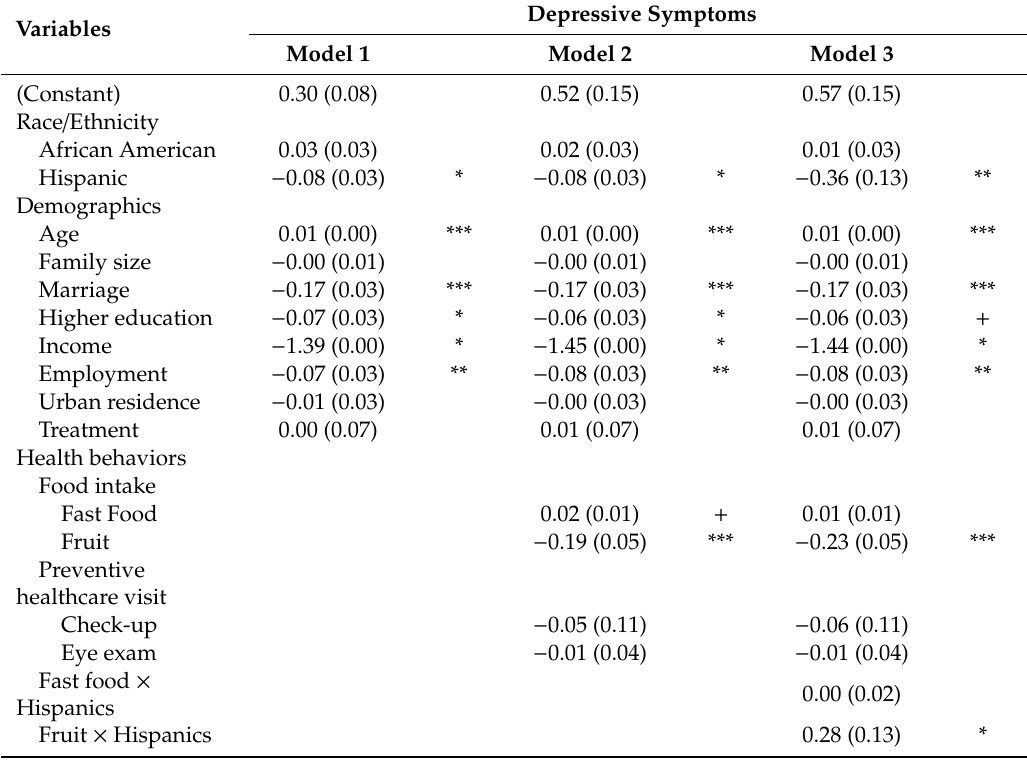
Table 4. Regression results of unstandardized coefficients (standard error) predicting depressive